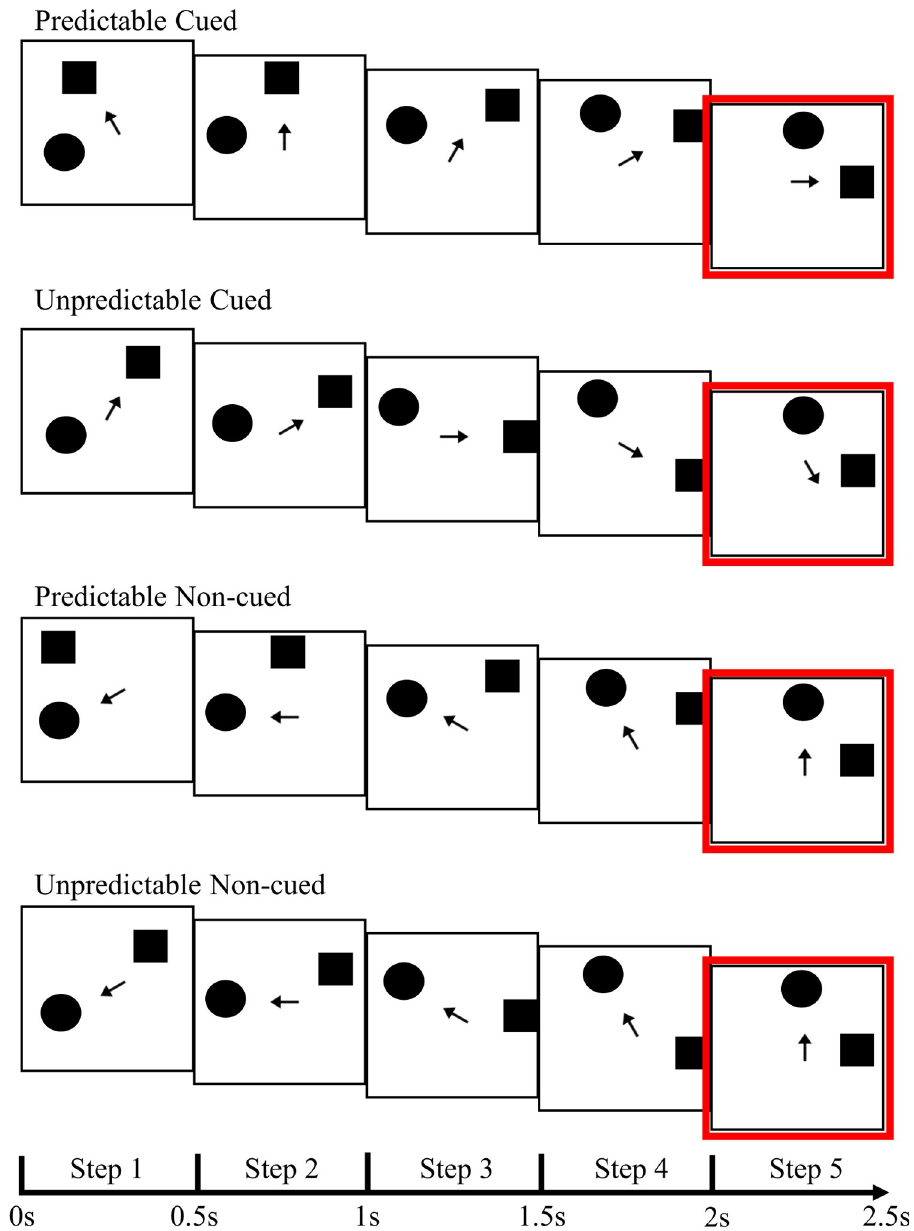
Fig 1. Examples of all conditions. Example of one sequence for each of the four conditions. Stimulus duration as indicated, 0ms intertrial interval, 500ms intersequence interval. Conditions are named with respect to lateralised shape status in the fifth trial, as outlined in red. All conditions were equal in low-level visual properties of the two shapes (excluding the arrow) in the critical final trial.